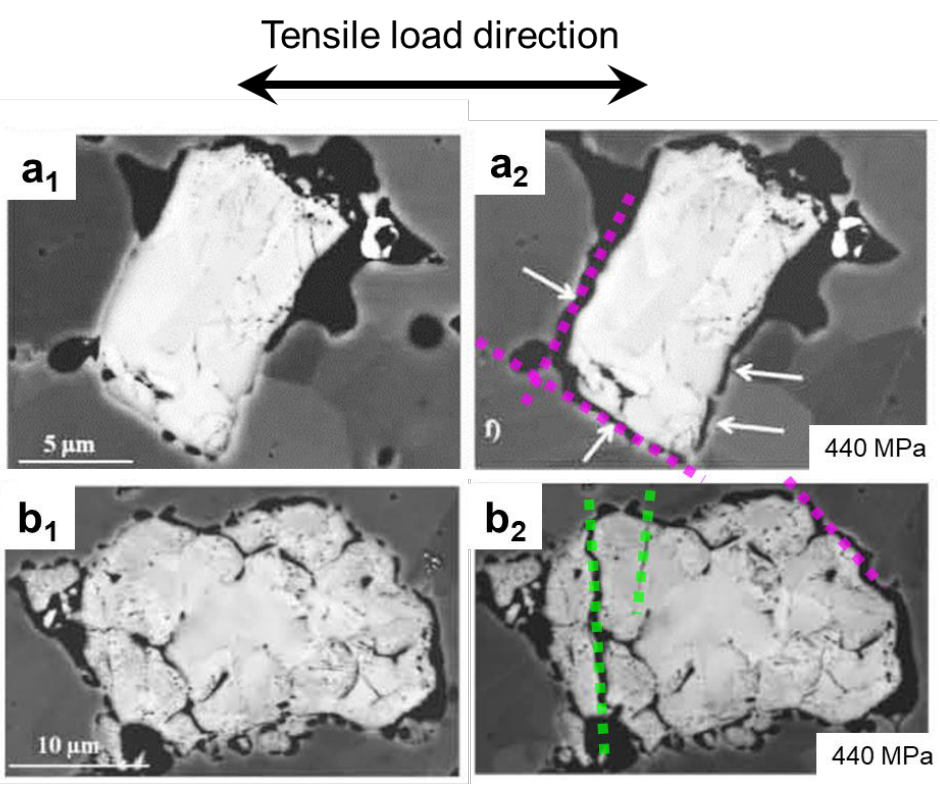
Figure 9. In-situ tensile test results of similar material at 6% of global strain, where around ( a1 ) a zirconia particle ( a2 ) delamination of ceramic/matrix interface is observed, which is shown with the help of magenta dotted plane, and ( b1 ) zirconia particle ( b2 ) brittle damage progression is observed which is shown with the help of light green dotted lines. Figure adapted from previously published work [13] with kind permission of TransTech Publications.